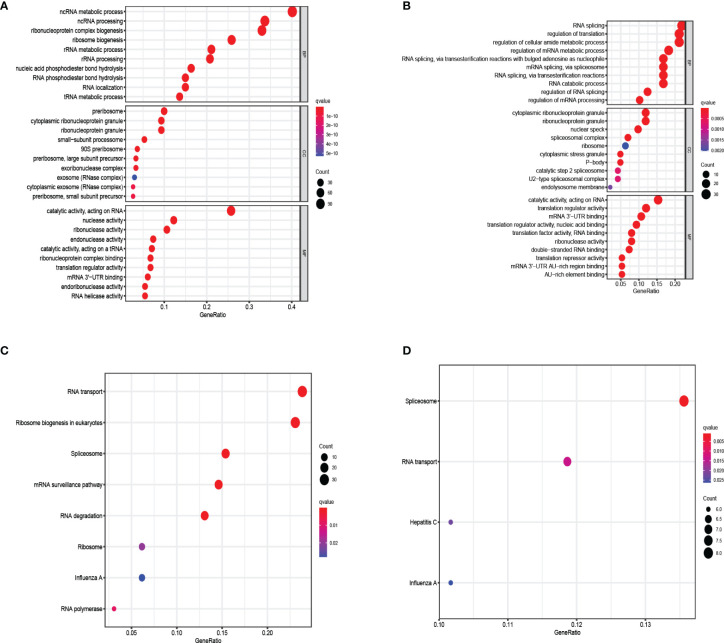
KEGG pathway and GO enrichment analysis of aberrantly expressed RBPs. (A) Enrichment of up-regulated RBPs in GO. (B) Enrichment of down-regulated RBPs in GO. (C) Enrichment of up-regulated RBPs in KEGG. (D) Enrichment of down-regulated RBPs in KEGG.